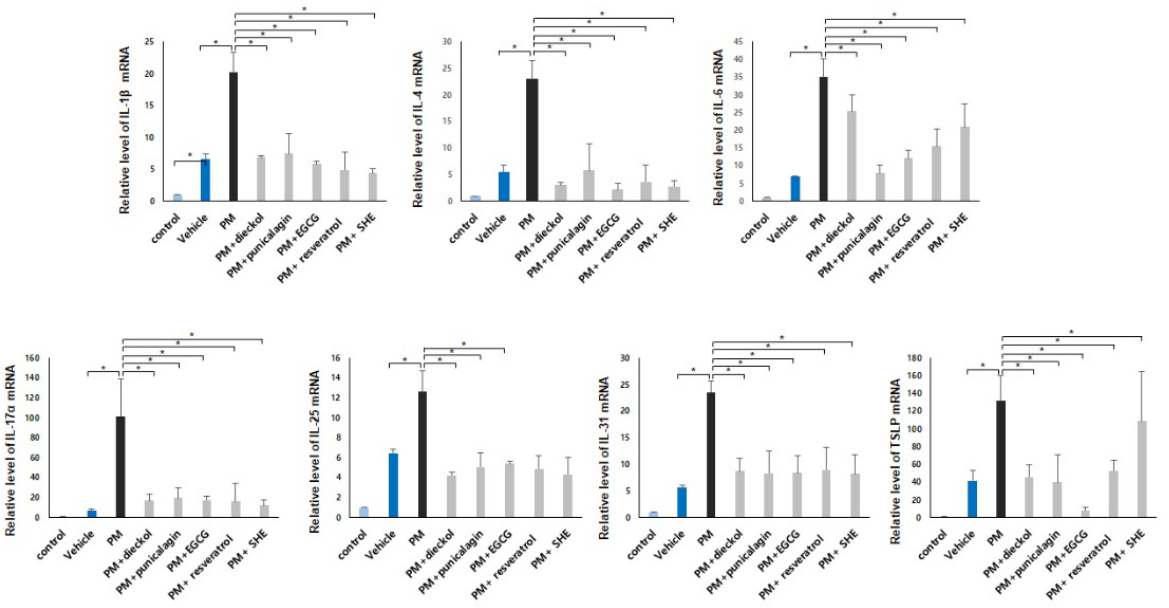
Figure 4. Preventative effects of antioxidants on the upregulation of inflammatory cytokines gene expression in the particulate matter <10 μm (PM 10 )-treated, 2,4-dinitrochlorobenzene (DNCB)-induced atopic dermatitis mice. The gene expressions of interleukin (IL)- 1β, IL -4, IL-6, IL- 17α, IL -25, IL-31, and thymic stromal lymphopoietin (TSLP) were significantly decreased after combined treatment with dieckol, punicalagin, epigallocatechin-3-gallate (EGCG), resveratrol, or Siegesbeckiae Herba extract (SHE) compared with that after PM 10 treatment only. The data in the bar graphs represent the mean ± standard deviation (SD) of three independent experiments (* p < 0.05).